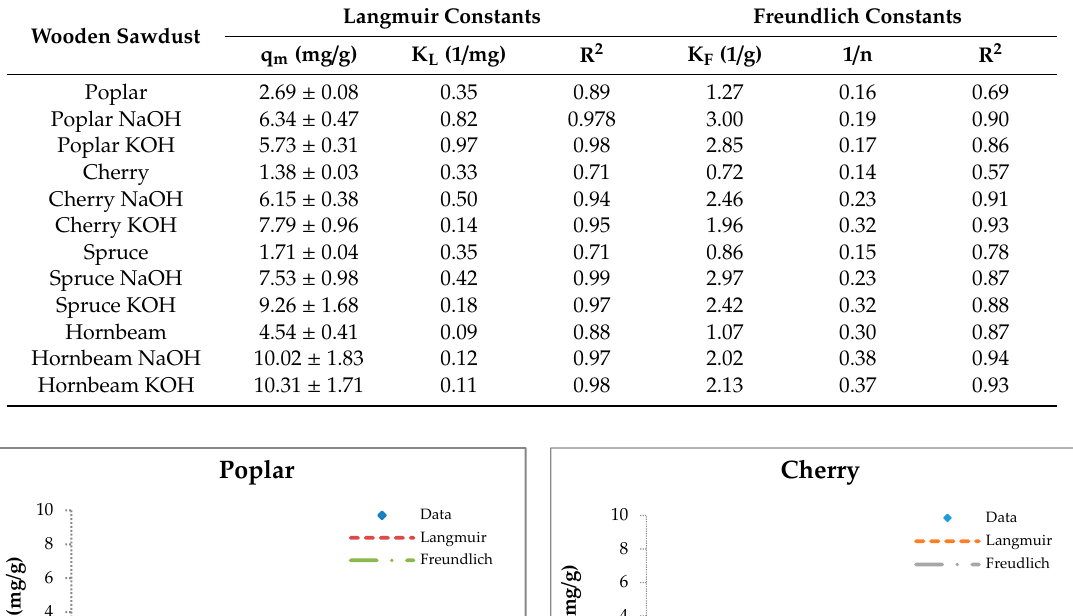
Table 3. Langmuir constants for zinc sorption by wooden